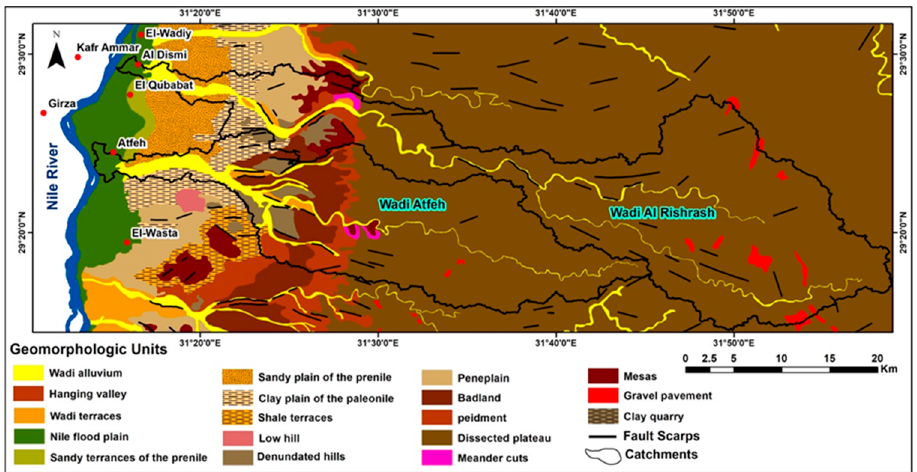
Figure 3. Geomorphological map of the Wadi Al Rishrash and Wadi Atfeh catchments showing the major landforms in the study area.